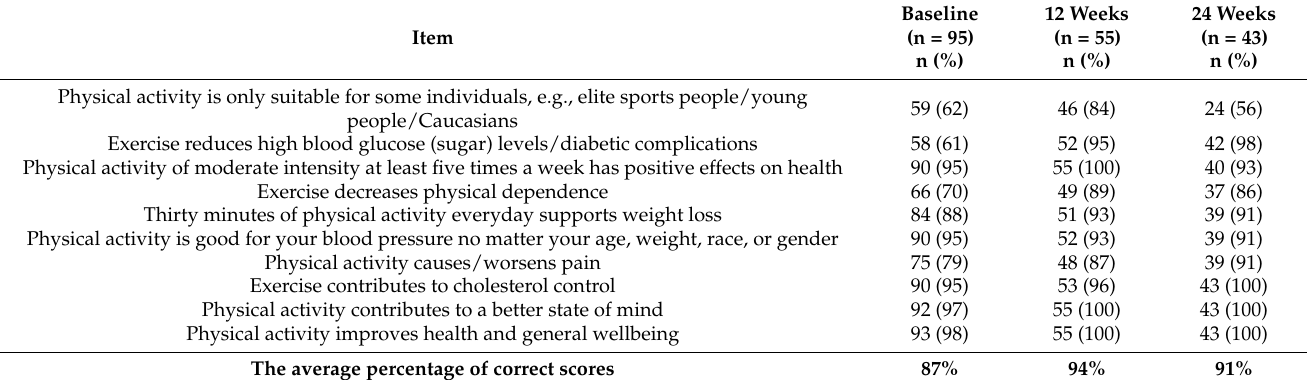
Table 5. Number and percentage of participants who scored correct answers for the physical activity survey at baseline, 12 weeks, and 24 weeks post supervised exercise intervention.